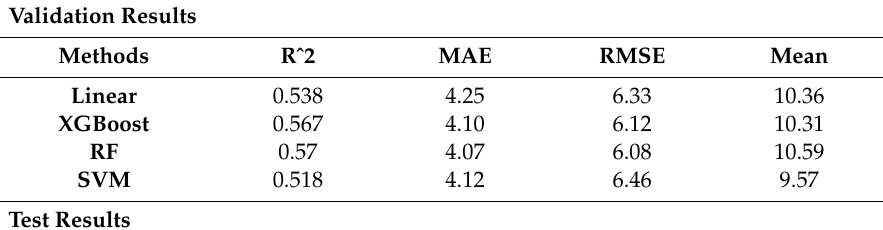
Table 5. Accuracy Metrics for Each Method, in kWh.